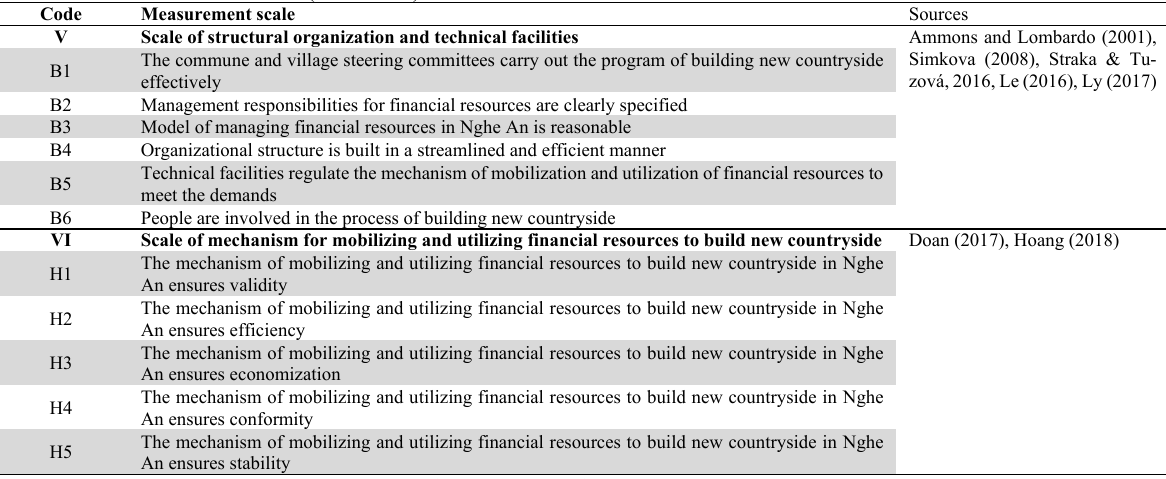
The results of testing the reliability of the scale